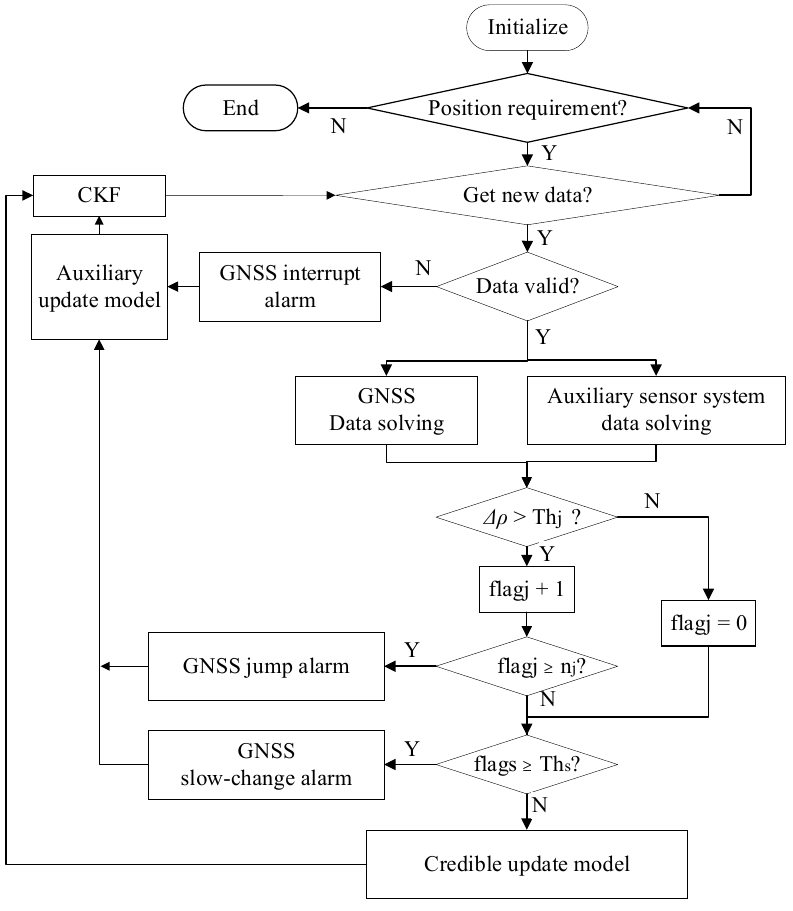
Figure 5. Algorithm flowchart.